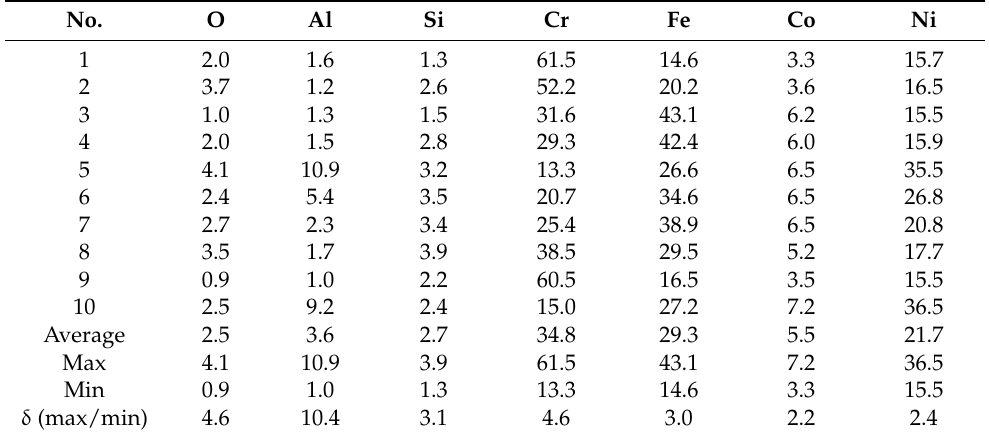
Figure 5 was obtained during the study by STEM. The EDS analysis of foils was used to investigate the elemental composition of dendrites and zones between dendrites in the surface layer of a HEA modified by a pulsed electron beam with the energy density of an electron beam set at E S = 10 J/cm 2 . Figure 5 provides STEM images with indicated zones, where the elemental composition was analyzed. The results of this analysis are listed in Table 2. It is suggested, based on the initial sample’s microstructure (Figures 2 and 3), that the zones between dendrites (the zones numbered 1, 2, 8, 9) are also enriched mainly with Cr atoms. Its content in these areas varies from approx. 38 to 61 at. % Dendrites (the zones under study numbered 4, 5, 6, 7, 10) are enriched with chemical elements such as Al, Ni, and Fe. Atoms of Co are distributed homogenously in the volume of an ingot. The most liquating element of the alloy is revealed to be Al (which has a liquation coefficient δ = 10.4), while the least liquating element is Co ( δ = 2.2). O and Si are also present in these areas of the microstructure and their content varies between 0.9 and 4.1 at. % and between 1.3 and 3.9 at. %, respectively. Table 2. The TEM-EDS elemental mapping outcomes (at. %) of the foil section presented in Figure 5. No. O Al Si Cr Fe